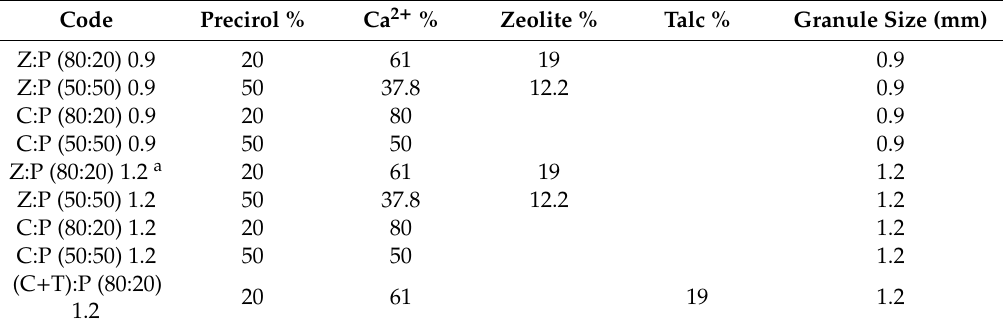
Table 1. Characteristics of